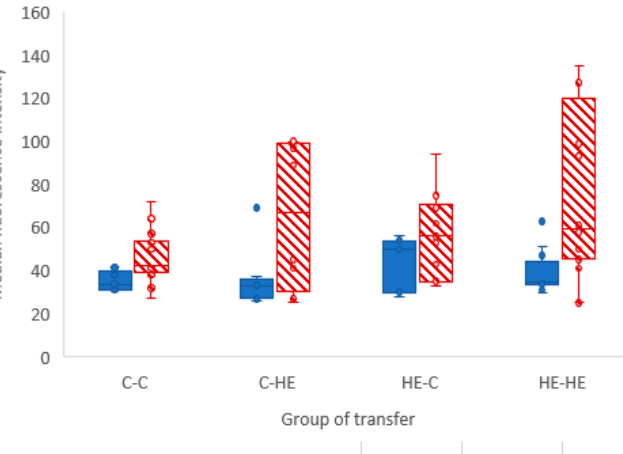
Figure 9. Median (+ range) intensity of 2-NBDG fluorescence for the allantochorionic (AC) and yolk-sac (YS) membranes recovered 21 days after transfer of day-7 embryos between Shetland pony mares on different feeding regimes (control to control mare, C-C; control to high-energy mare, C-HE; high-energy to control mare, HE-C; high-energy to high-energy mare, HE-HE.